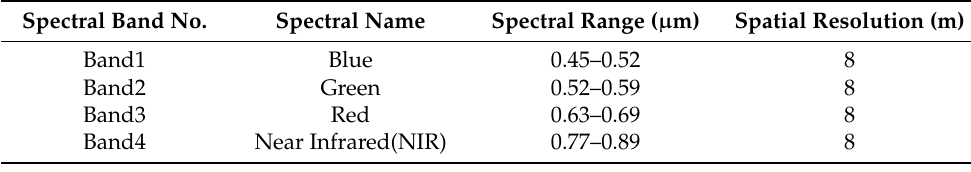
Table 2. Technical indicators of the GF-1 satellite payload.